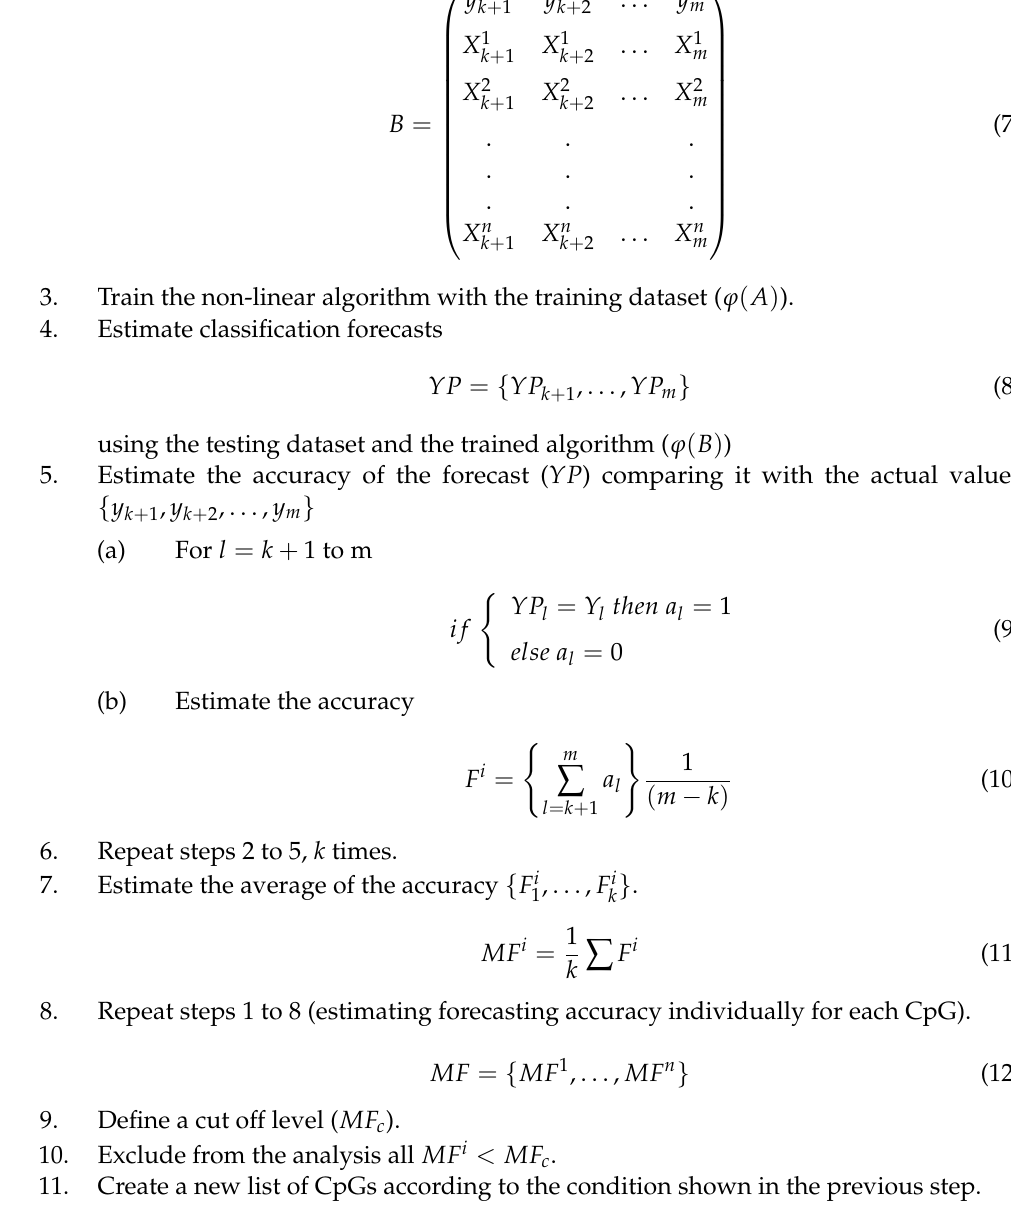
Define a cut off level ( MF c ). Exclude from the analysis all MF i < MF c .